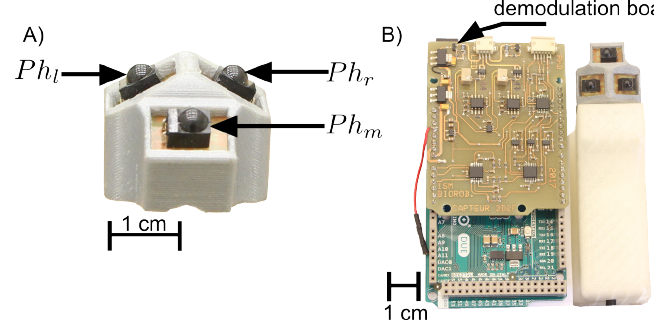
Figure 2. Description of the HyperCube hardware: ( A ) each photodiode is connected to an analog amplifier for the conversion of the photodiode current into an output voltage; and ( B ) the signal provided by the photodiodes is processed by a demodulation board shielded on an Arduino board.